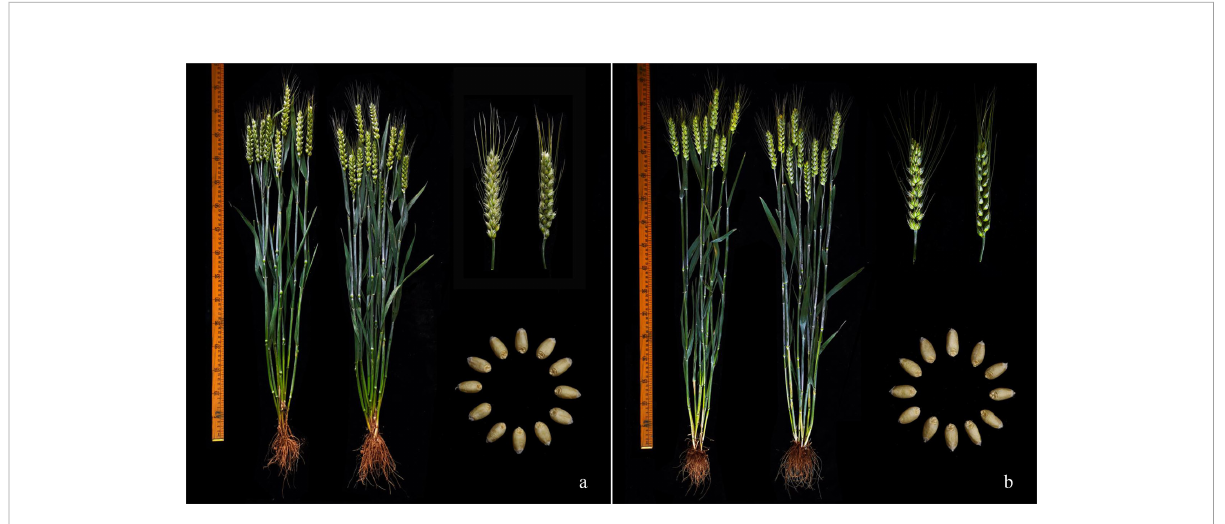
FIGURE 1 Morphological traits of wheat cultivar Yannong 31 (A) and Yannong 1212 (B)